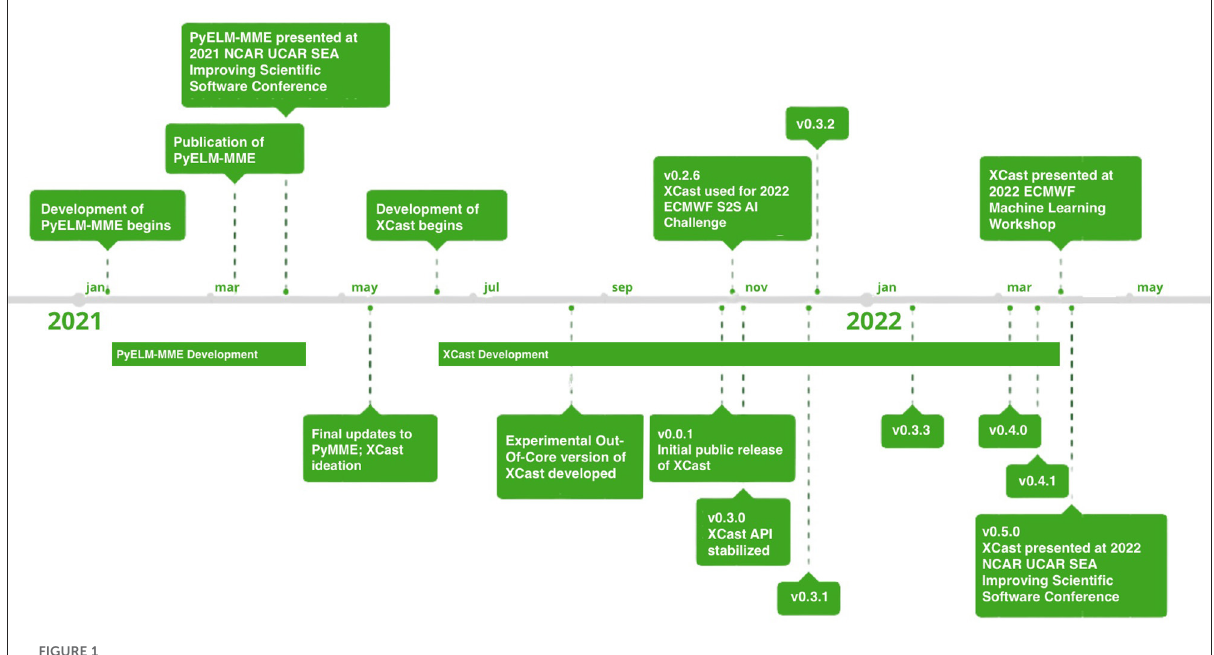
FIGURE1 A timeline of the development of XCast.